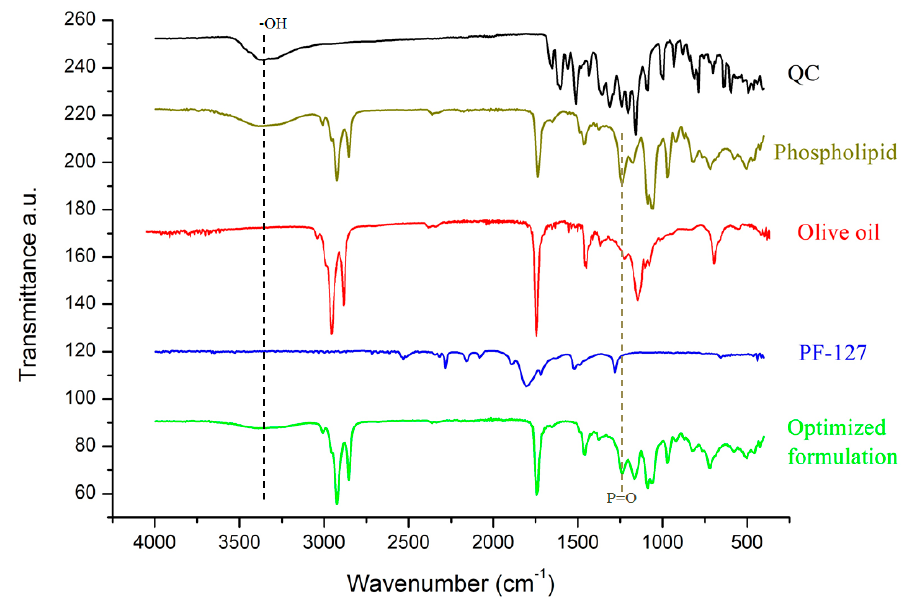
Figure 5. FT-IR spectra of QC, phospholipid, olive oil, PF-127 and optimized formulation.